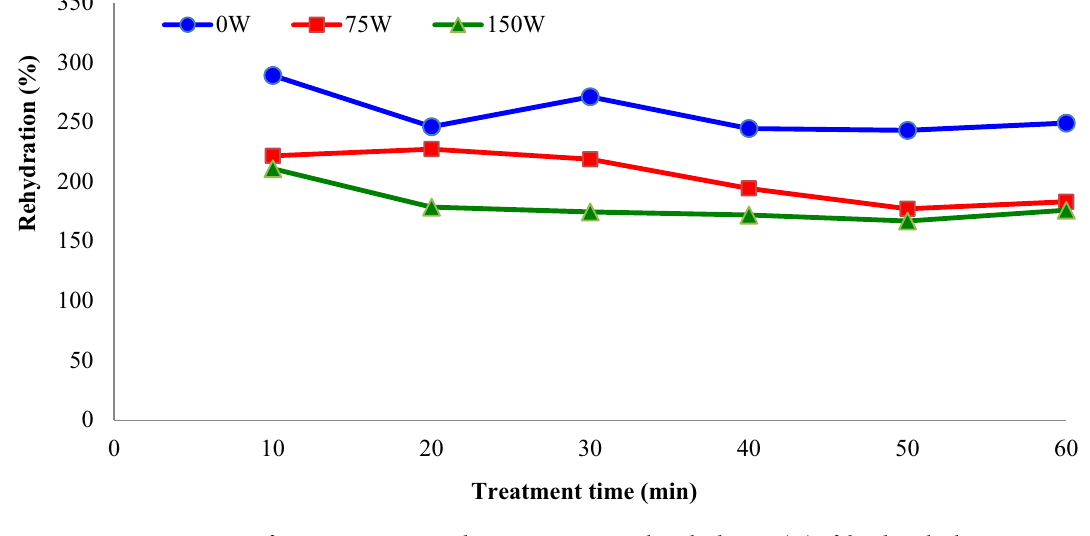
Figure 7. Impacts of sonication power and treatment time on the rehydration (%) of dried apple slices (concentration = 40° Brix).